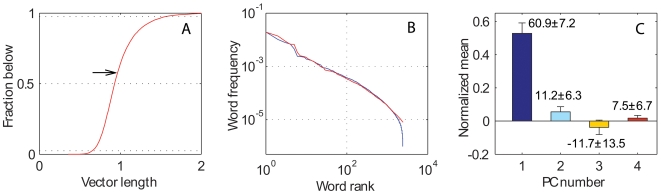
Semantic characteristics of the frequency of word usage.
A: cumulative distribution of vector length of all words in MS English, with dotted horizontal lines at the 2.5th, 50th, and 97.5th percentiles. The arrow indicates the mean weighted by the British National Corpus (BNC) frequency distribution. B: MS English word sorting by the frequency of their usage according to two independent sources (see Materials and Methods): Australian database (blue) and BNC (red). C: Values of the first 4 PCs of the weighted average of all words according to the Australian database frequencies. As in Figure 4, the bars and corresponding numbers represent the PC coordinate values and their percentage of the standard deviation of each PC (in the case of BNC frequencies, the corresponding numbers are: 64.0+7.5%, 13.3+6.4%, −15.4+11.9%, and 10.2+6.4%). Standard errors are reported for both bars (as whiskers) and numbers. Only the first component is statistically significant.